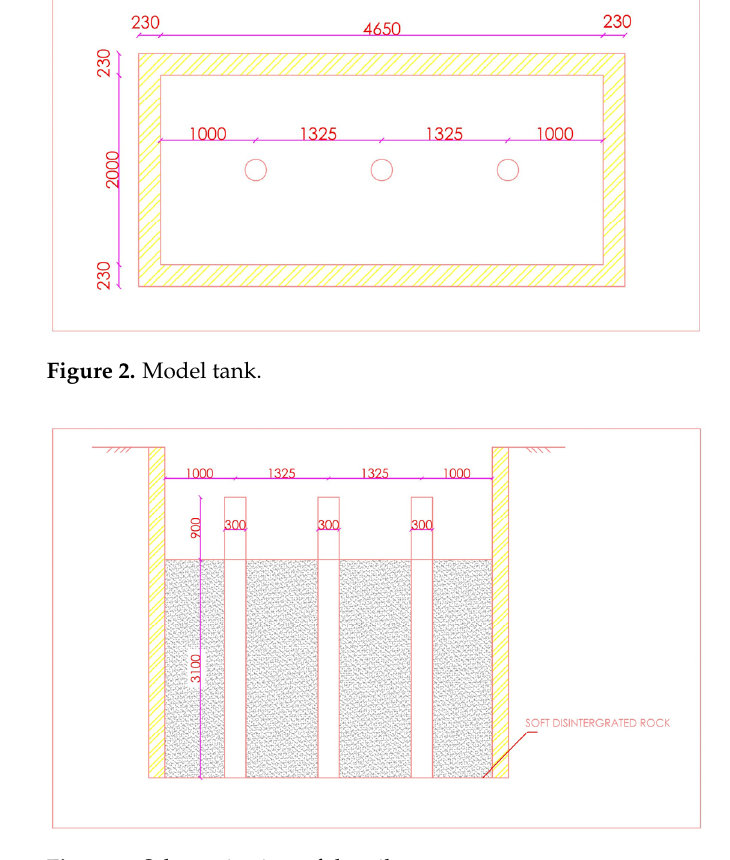
Figure 3. Schematic view of the pile setup.